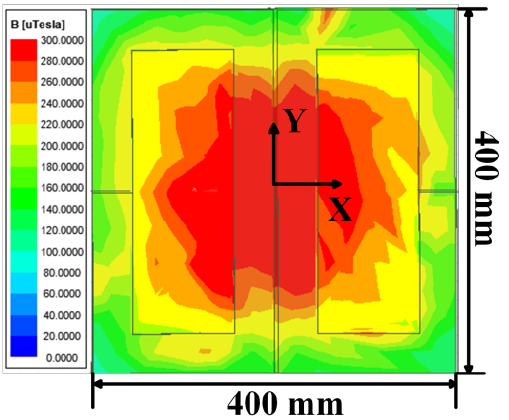
Figure 9. Magnetic field distribution of the optimal regular DD coil.